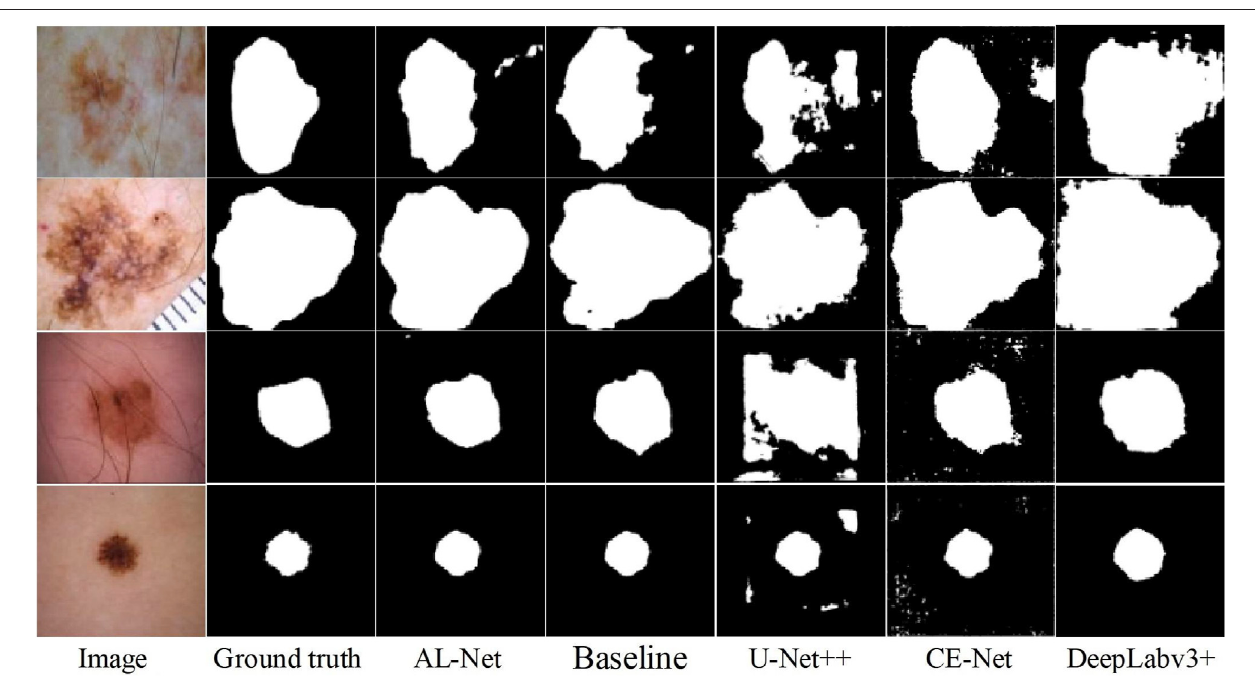
FIGURE 7 | The segmentation results using six models for skin lesions